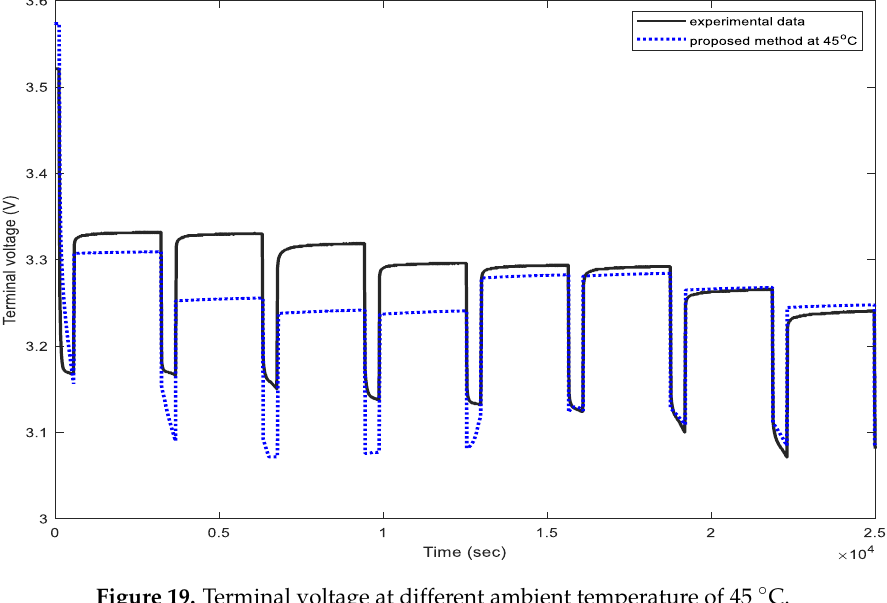
Figure 19. Terminal voltage at different ambient temperature of 45 °C. Table 2. RMSEs of terminal voltage at different ambient